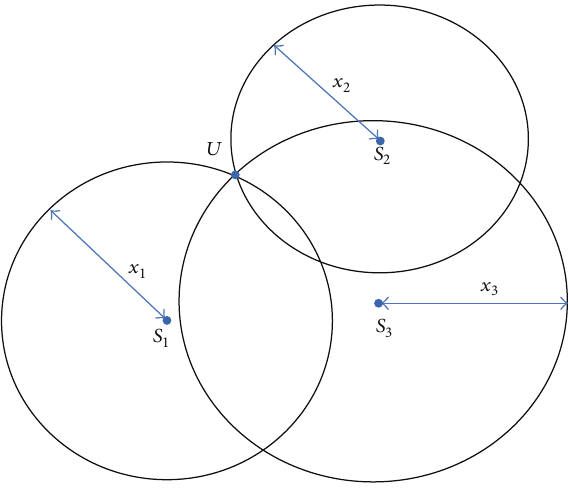
Figure 1: Two-dimensional user